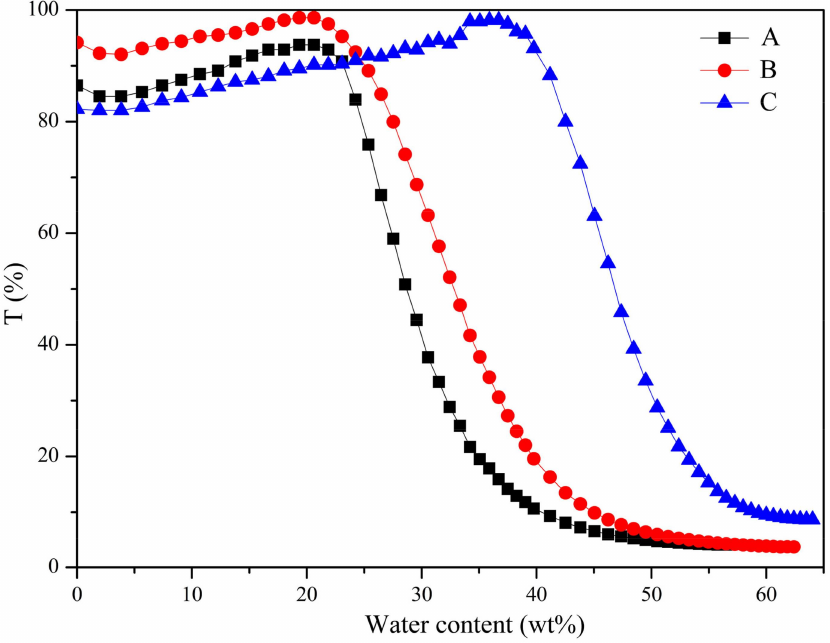
Figure 7. Relationships between light transmission at 267 nm and water content for the self-assembly behavior of the different copolymer structures (A) m PEG 43 - b -P[(TMC-C) 20 TMC 20